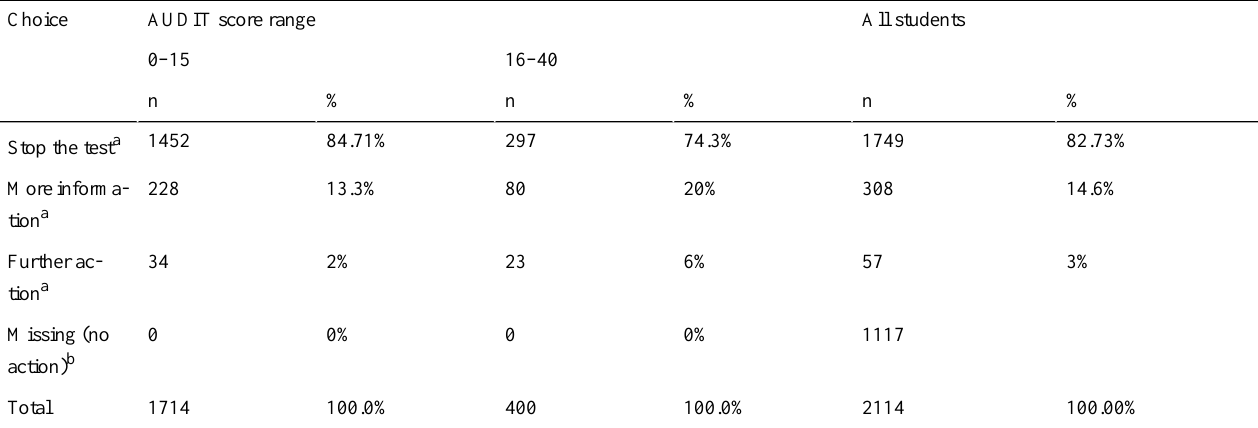
Table 4. Alcohol Use Disorders Identification Test (AUDIT) score for college and university students vs. choices for follow-up.